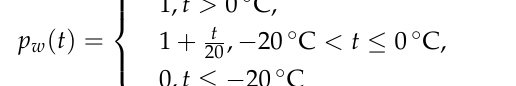
Weather Pinnate (Ci) Cirrocumulus (Cc) Cumulonimbus (Cb) Cirrocumulus (Cc) Pinnate (Ci) Stratocumulus (Sc) Cumulonimbus (Cb) Layered (St) Nimbostratus (Ns) Altocumulus (Ac) Altostratus (As) Stratocumulus (Sc) Stratocumulus (Sc) Layered (St) Layered (St) Cumulus (Cu) Altocumulus (Ac) Cumulonimbus